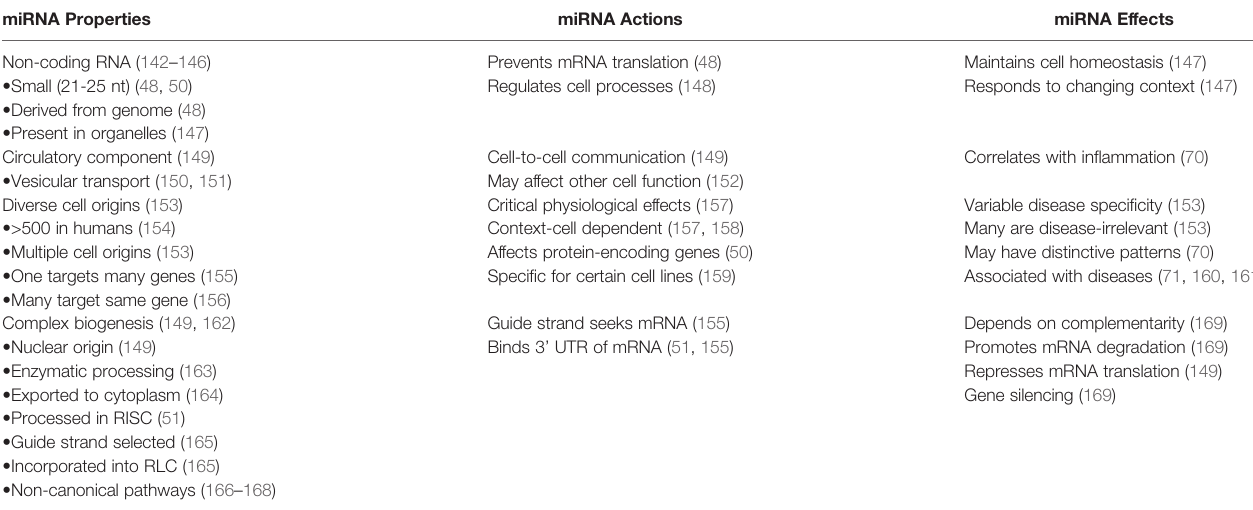
TABLE 2 | Epigenetic Properties and Effects of Micro-Ribonucleic